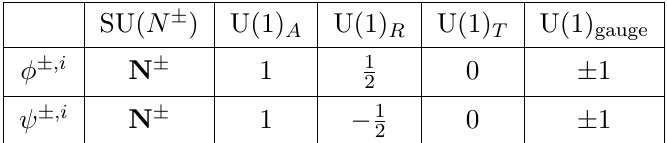
Table 1 . Representations of matter (cid:12)elds for the (cid:6) charged chiral (cid:12)eld for the global and gauge